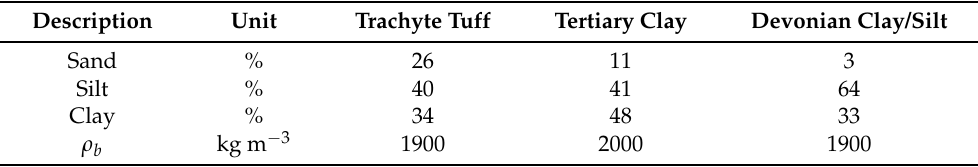
Table 1. Particle size distribution and bulk density of each soil layer of the Dollendorfer Hardt test site (derived from Schmidt [38]).